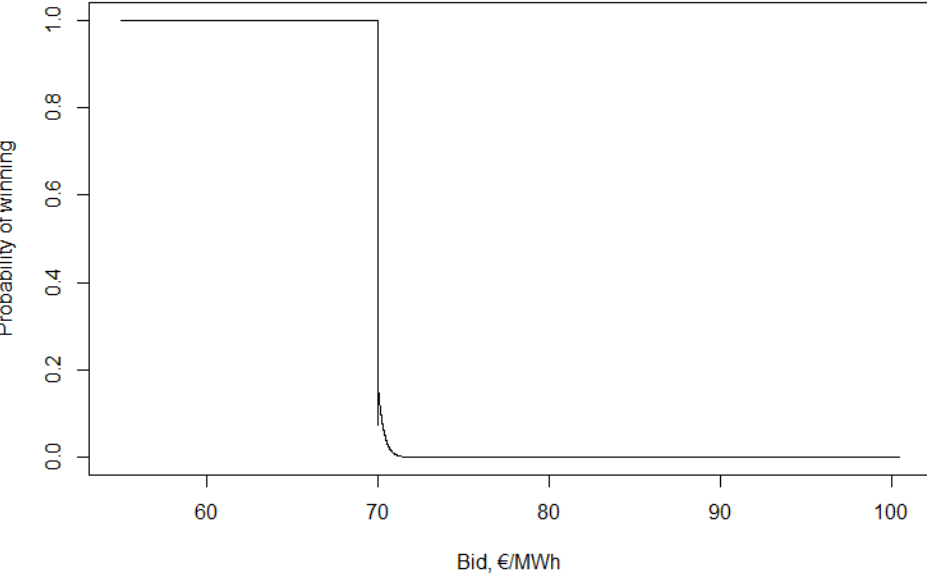
Figure A12. Probability of winning in case of different bids, assuming F N bid distribution, source: own